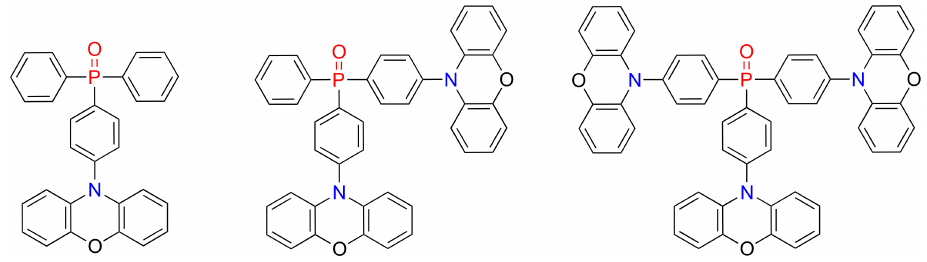
Figure 4. TADF emitters comprising a phosphine oxide